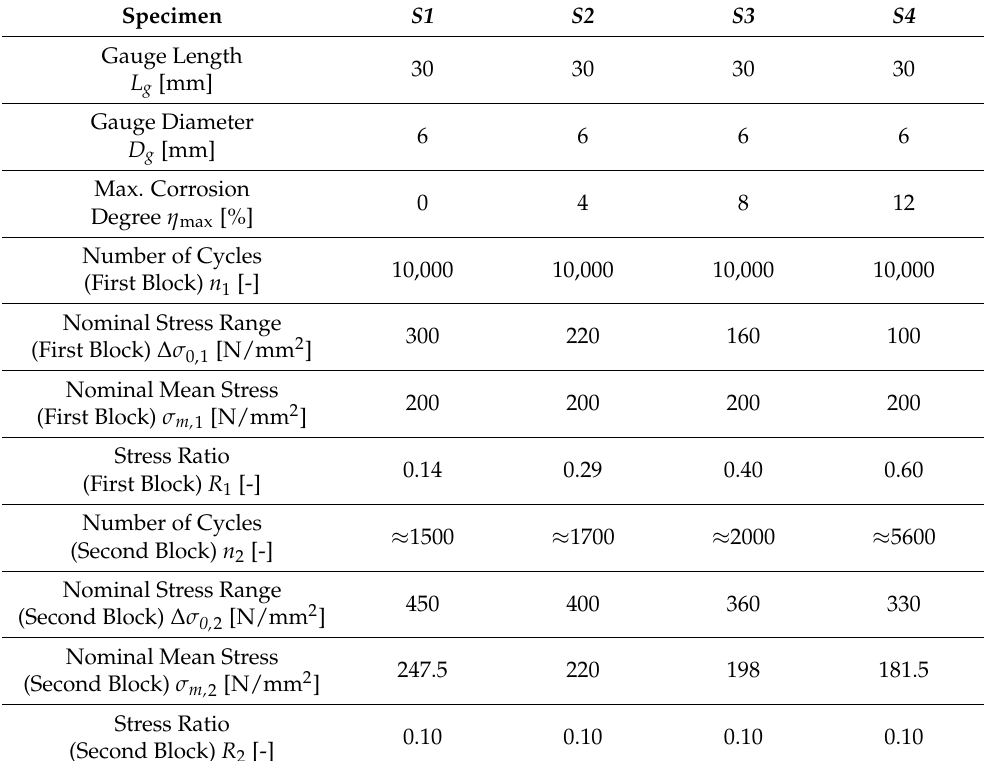
Table 2. Test conditions for corrosion HCF+LCF tests on AH32 steel performed by Sun et al. [24] (Specimens S1–S4